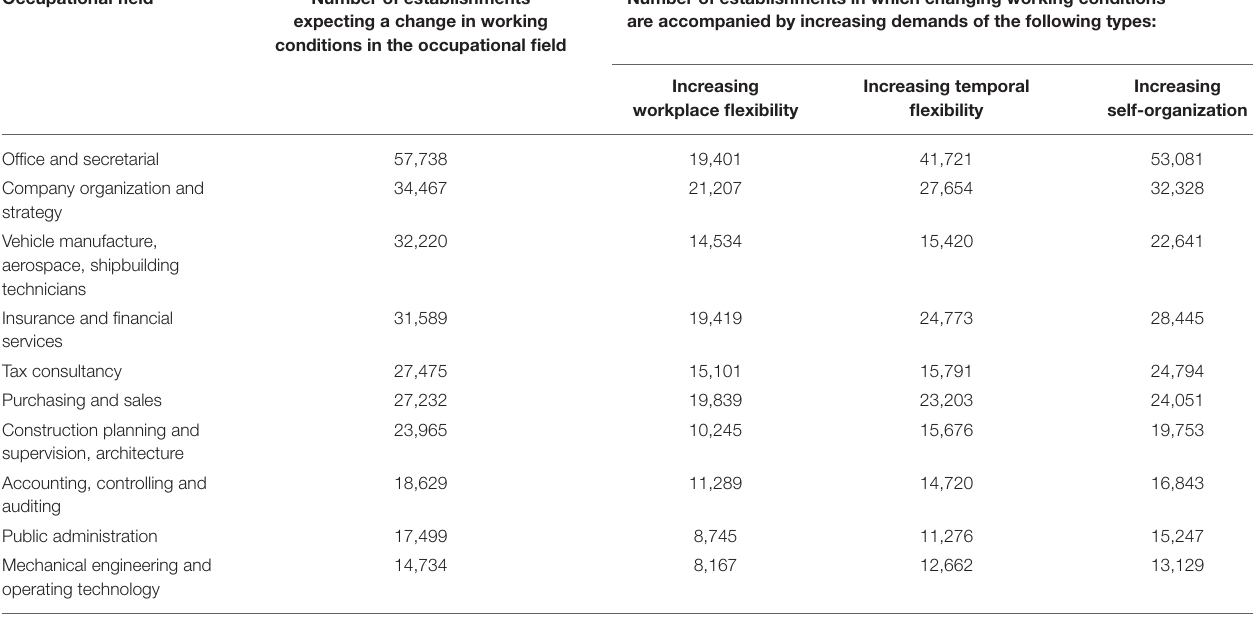
TABLE 4 | Number of establishments with positive expectations of increasing flexibility requirements in the respective occupation. Occupational